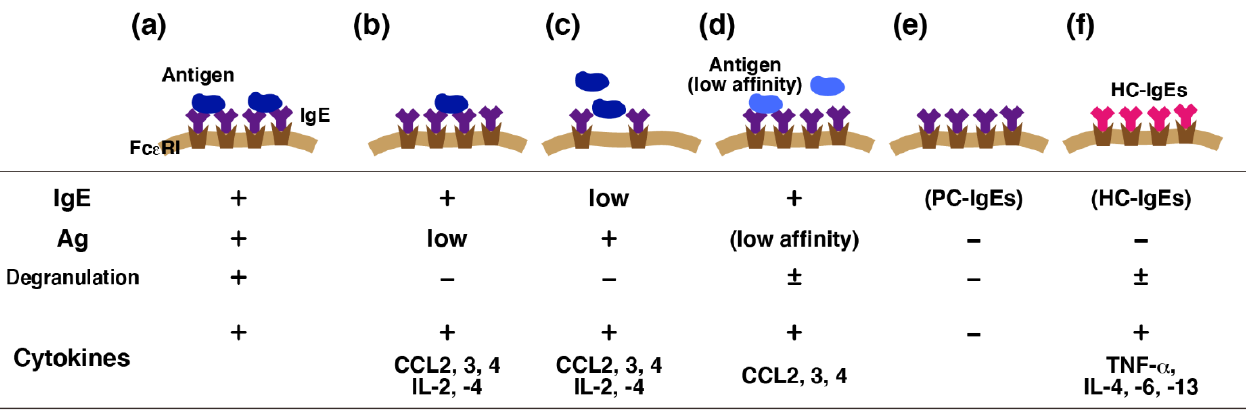
Figure 2. Finely tuned Fc ε receptor I (Fc ε RI)-mediated activation of mast cells. Immunoglobulin E (IgE)-mediated antigen stimulation triggers both degranulation and release of various cytokines ( a ). Accumulating evidence suggests that different sets of mediators should be released from activated mast cells without degranulation. Early studies indicated that several chemokines and cytokines are released from mast cells upon weak antigen (Ag) stimulation without degranulation ( b , c ). Such preference was also observed in mast cells activated by antigens with low affinity to IgE ( d ). Poorly cytokinergic (PC)-IgEs were found only to prevent apoptosis of mast cells, whereas highly cytokinergic (HC)-IgEs were found to induce a massive cytokine release ( e , f ). This variation may affect the local immune responses, such as the leukocyte